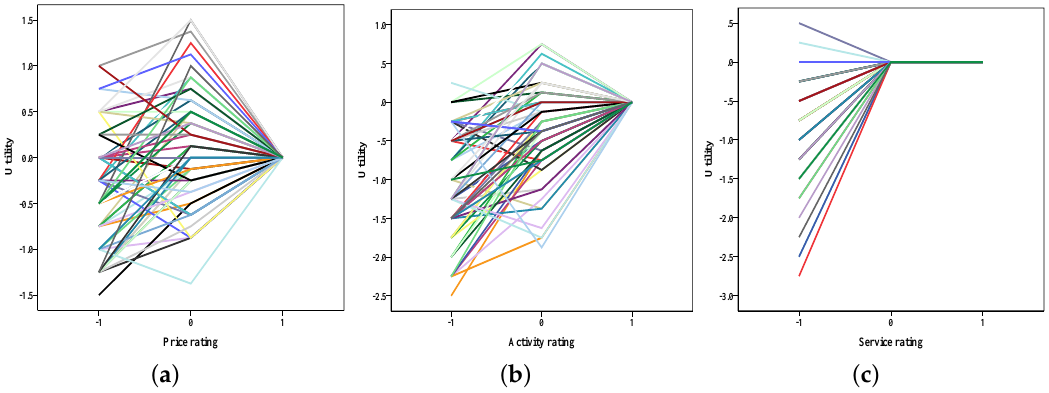
Figure 3. Utility plot of attributes in Dalishu scenic spots (( a ) utility change with price rating; ( b ) utility change with activity rating; ( c ) utility change with service rating).